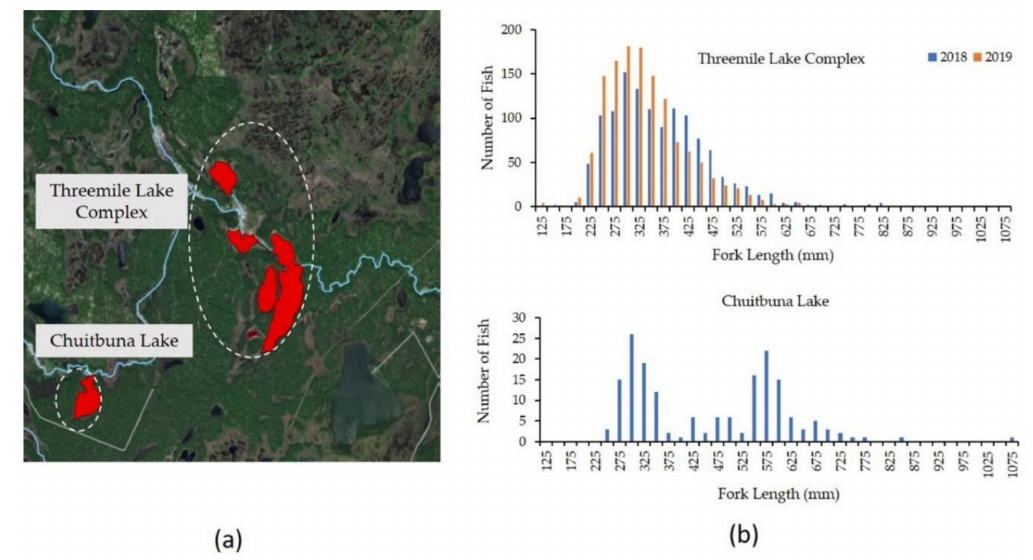
Figure 8. ( a ) Map of west side Cook Inlet pike suppression projects and ( b ) length-frequency distributions of pike removed to